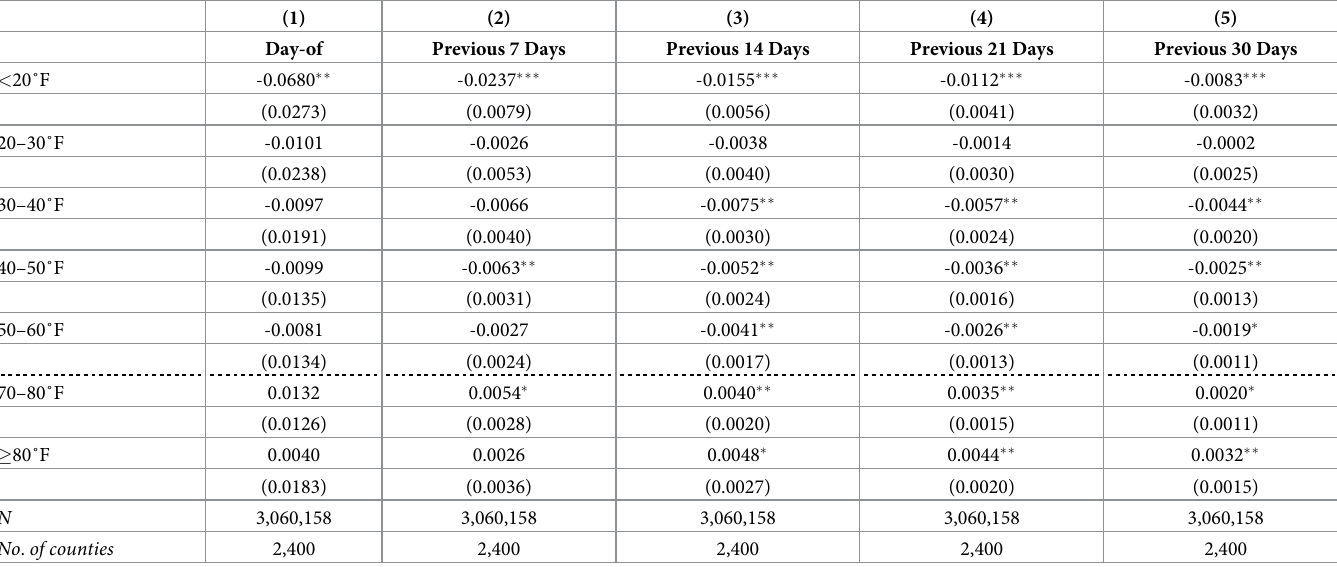
Table 3. Effect of temperature on the probability of self-reported mental health difficulties: Alternative